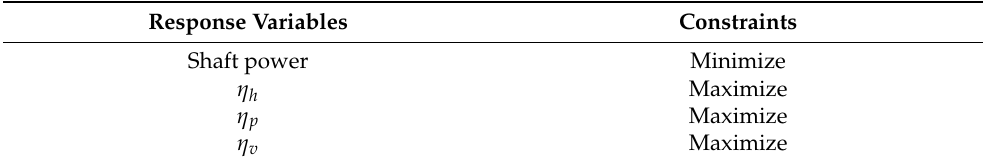
Table 3. Response variables and their